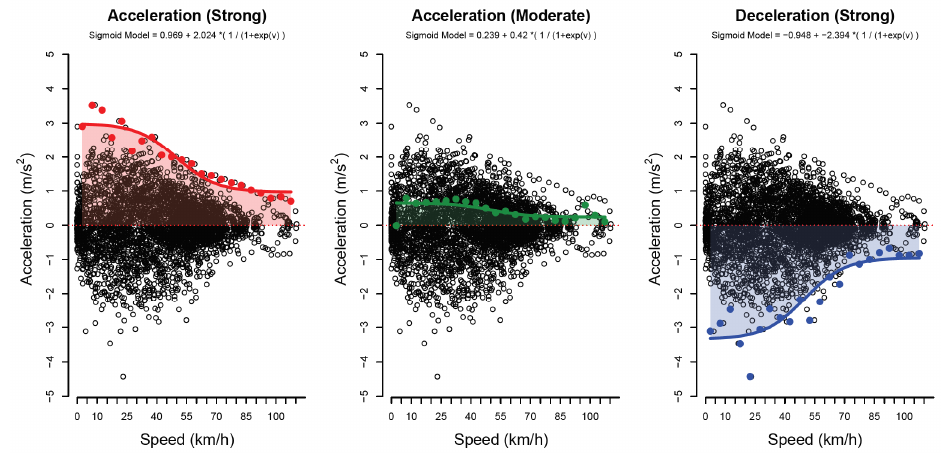
Figure 4. Developing speed / acceleration functions from real-world drive cycles; red, green and blue solid dot points show the binned (5 km / h bins) maximum, median and minimum acceleration values; the corresponding coloured lines show the sigmoid models fitted to these points.